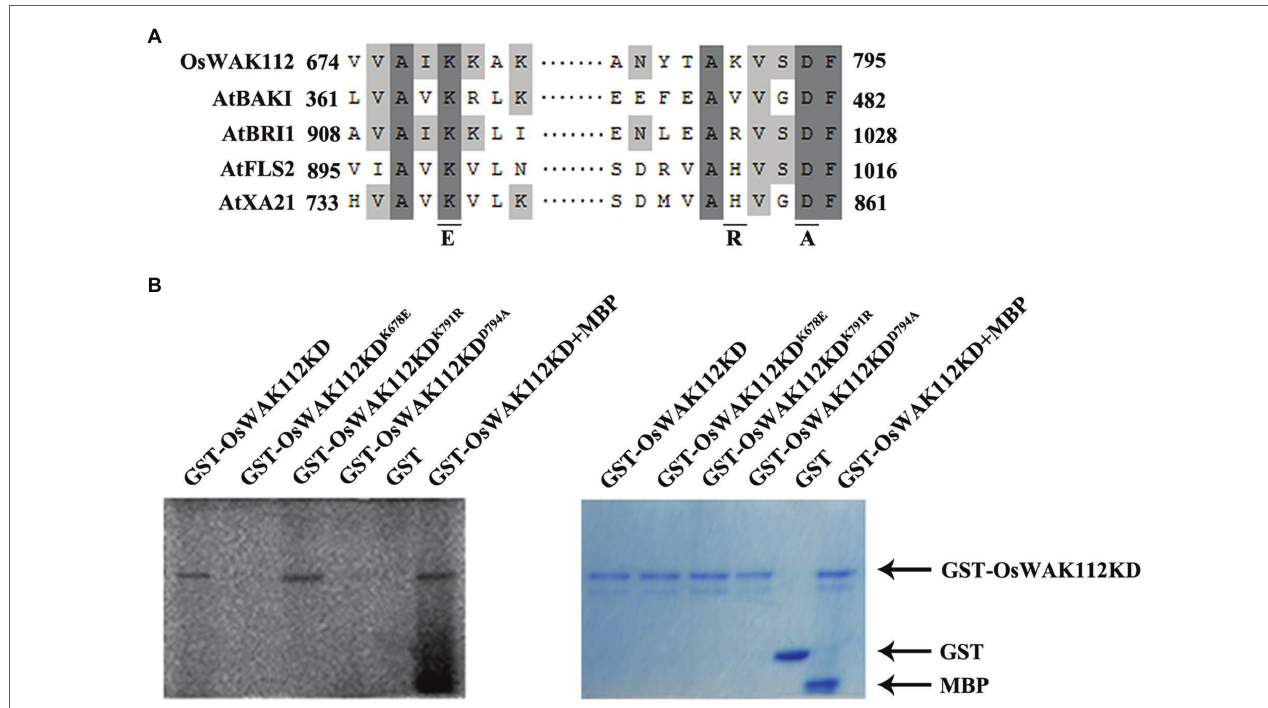
FIGURE 4 | OsWAK112 possesses kinase activity. (A) Alignment of a conserved motif from the OsWAK112KD with that from other known receptor-like kinases (RLKs). Underlines indicate conserved residues in the active kinase that were mutated to the indicated amino acid in the following experiment. (B) GST- OsWAK112KD showed autophosphorylation and substrate (MBP) phosphorylation. The mutated form GST-WAK112KD K791R also showed autophosphorylation, whereas the mutated forms GST-OsWAK112KD K678E and GST-OsWAK112KD D794A did not. The left panel shows autoradiography and the right panel Coomassie blue (CBB) staining of the